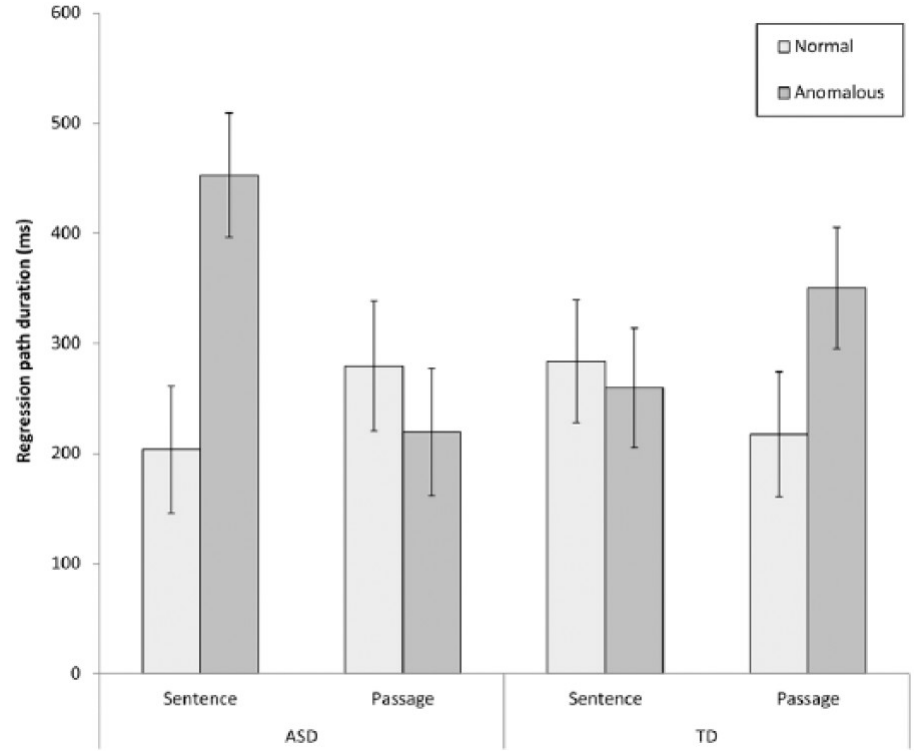
Figure 3 . Group and anomaly type interaction for regression path durations reported by Au-Yeung et al. (2017) [48]. Reproduced with permission from